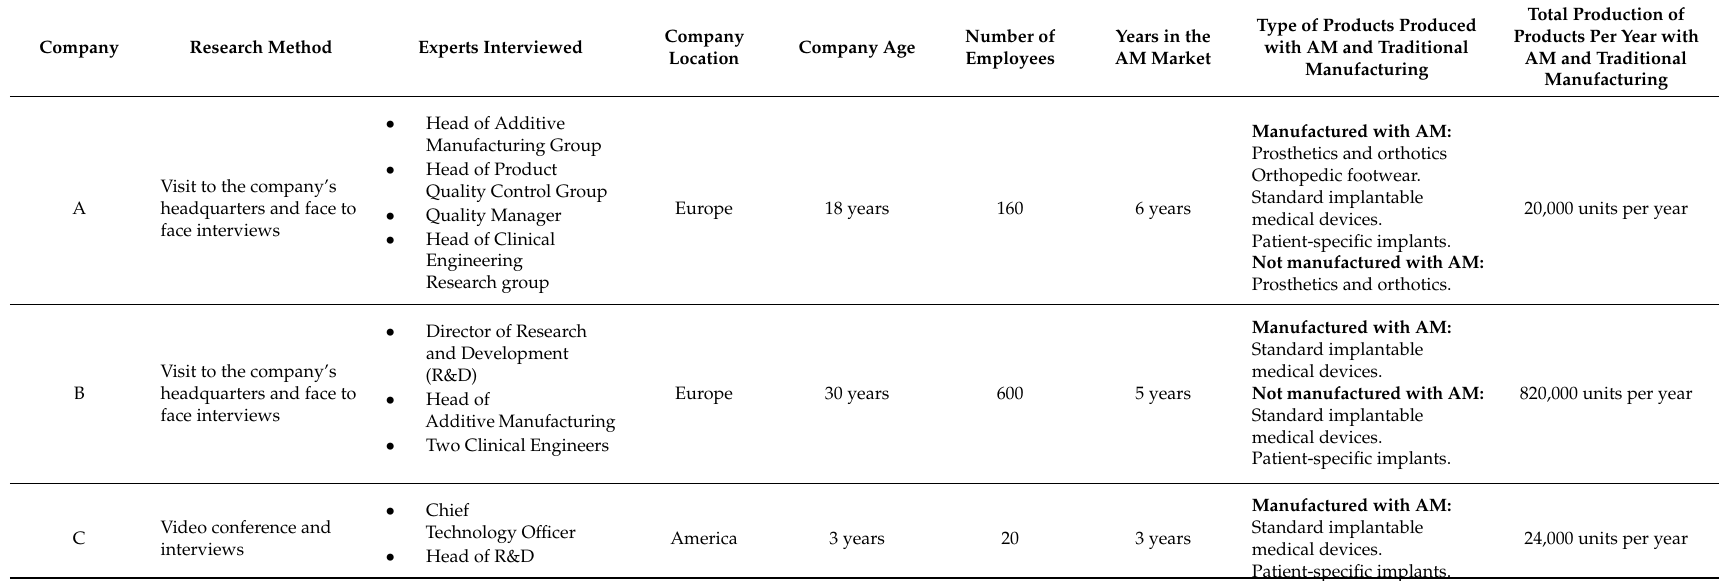
Table 3. Summary of companies’